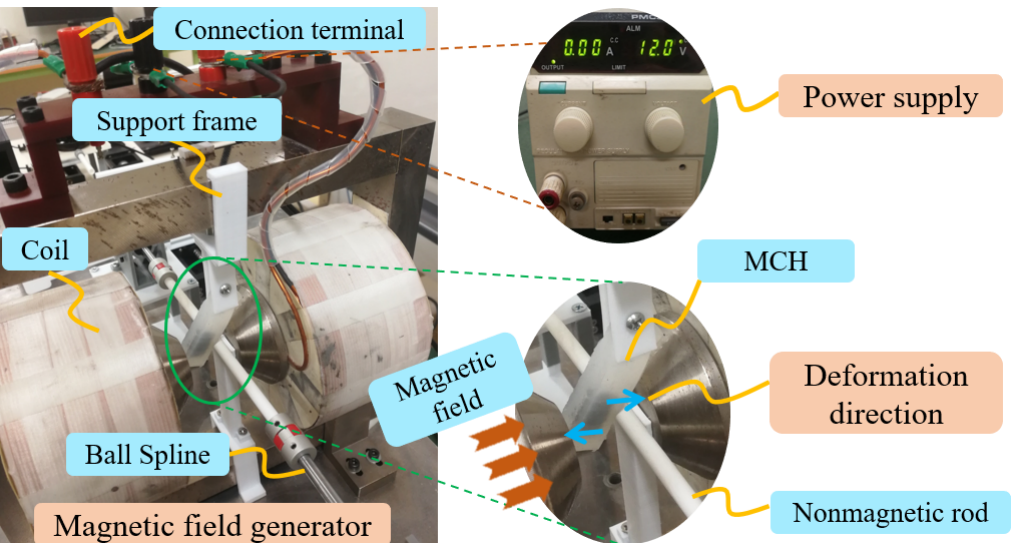
Figure 7. The magnetically controlled haptic force feedback based on MCH and the way to provide force feedback.